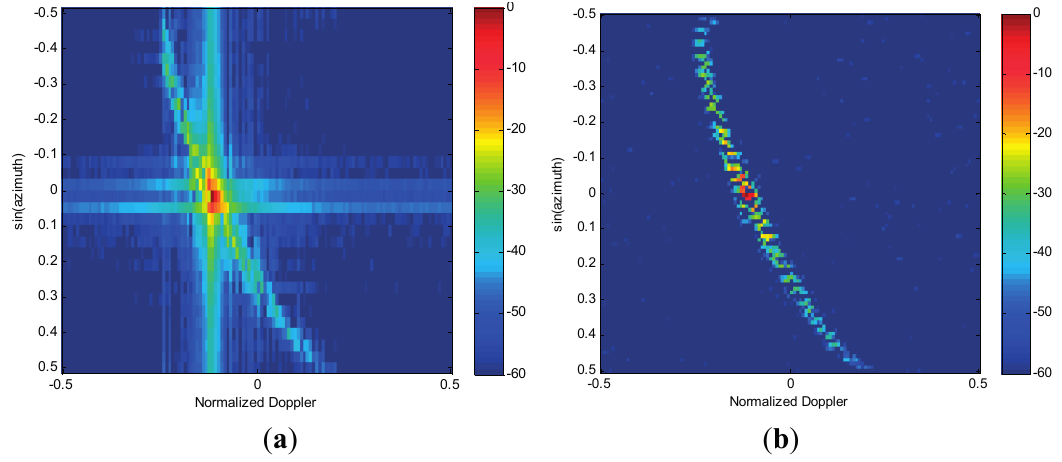
Figure 4. Angle-Doppler spectrum image. ( a ) 2D FFT. ( b ) reduced-dimension sparse reconstruction (RDSR).